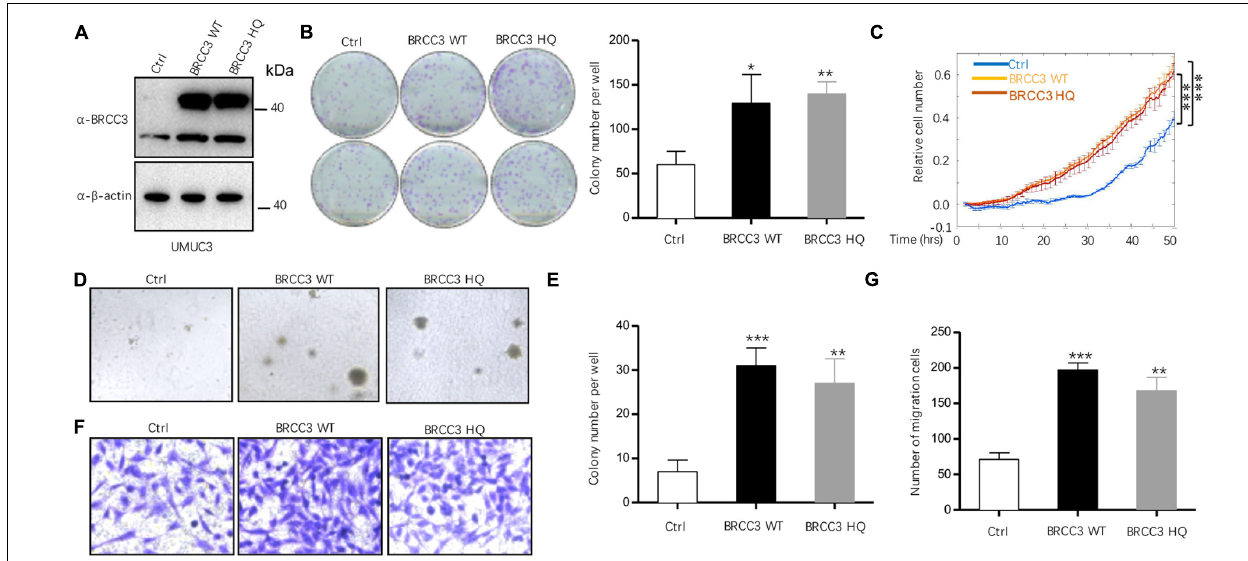
FIGURE 2 | The overexpression of BRCC3 increased tumor cell proliferation in vitro . (A) BRCC3-overexpressing cells were identified via immunoblotting. (B) Colony formation assays. The number of clones was counted and plotted. (C) An ECIS cell proliferation assay was performed. (D) Three-dimensional colony formation assay was performed in soft agar. The colony numbers are expressed as the means ± standard error of triplicate assays. (E) The Quantitative data show the colonies numbers in (D) . (F) Transwell migration assay. The relative cell numbers of migrating were statistically analyzed. (G) Quantitative data show the number of migrating cells in (F) . *P < 0.05, ** P < 0.001, and *** P < 0.001 compared with controls.